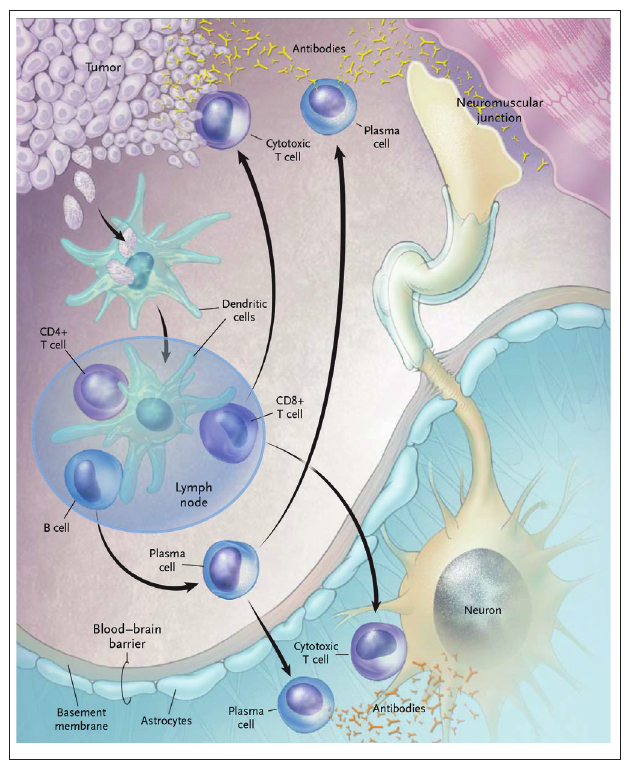
Fig. 1. Pathophysiology of PNS with activated CD-8 lymphocyte and plasma cell induced cell-mediated and humoral immune reaction to neural tissue resulting in target organ damage. (Reproduced with kind permission of Dr J B